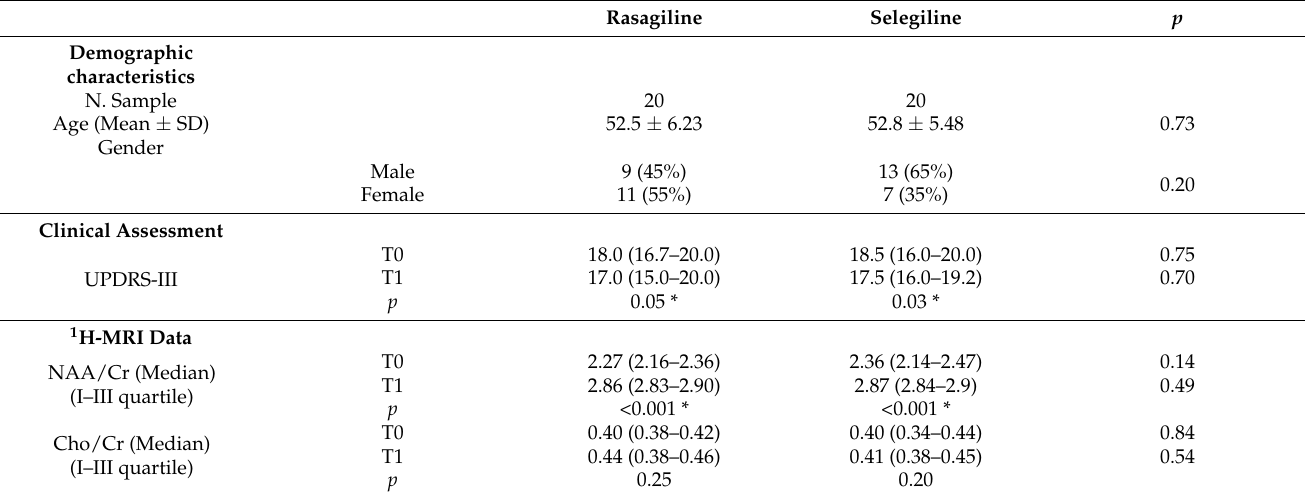
Table 2. Demographic and clinical and imaging characteristics of Rasagiline and Selegiline treatment patient